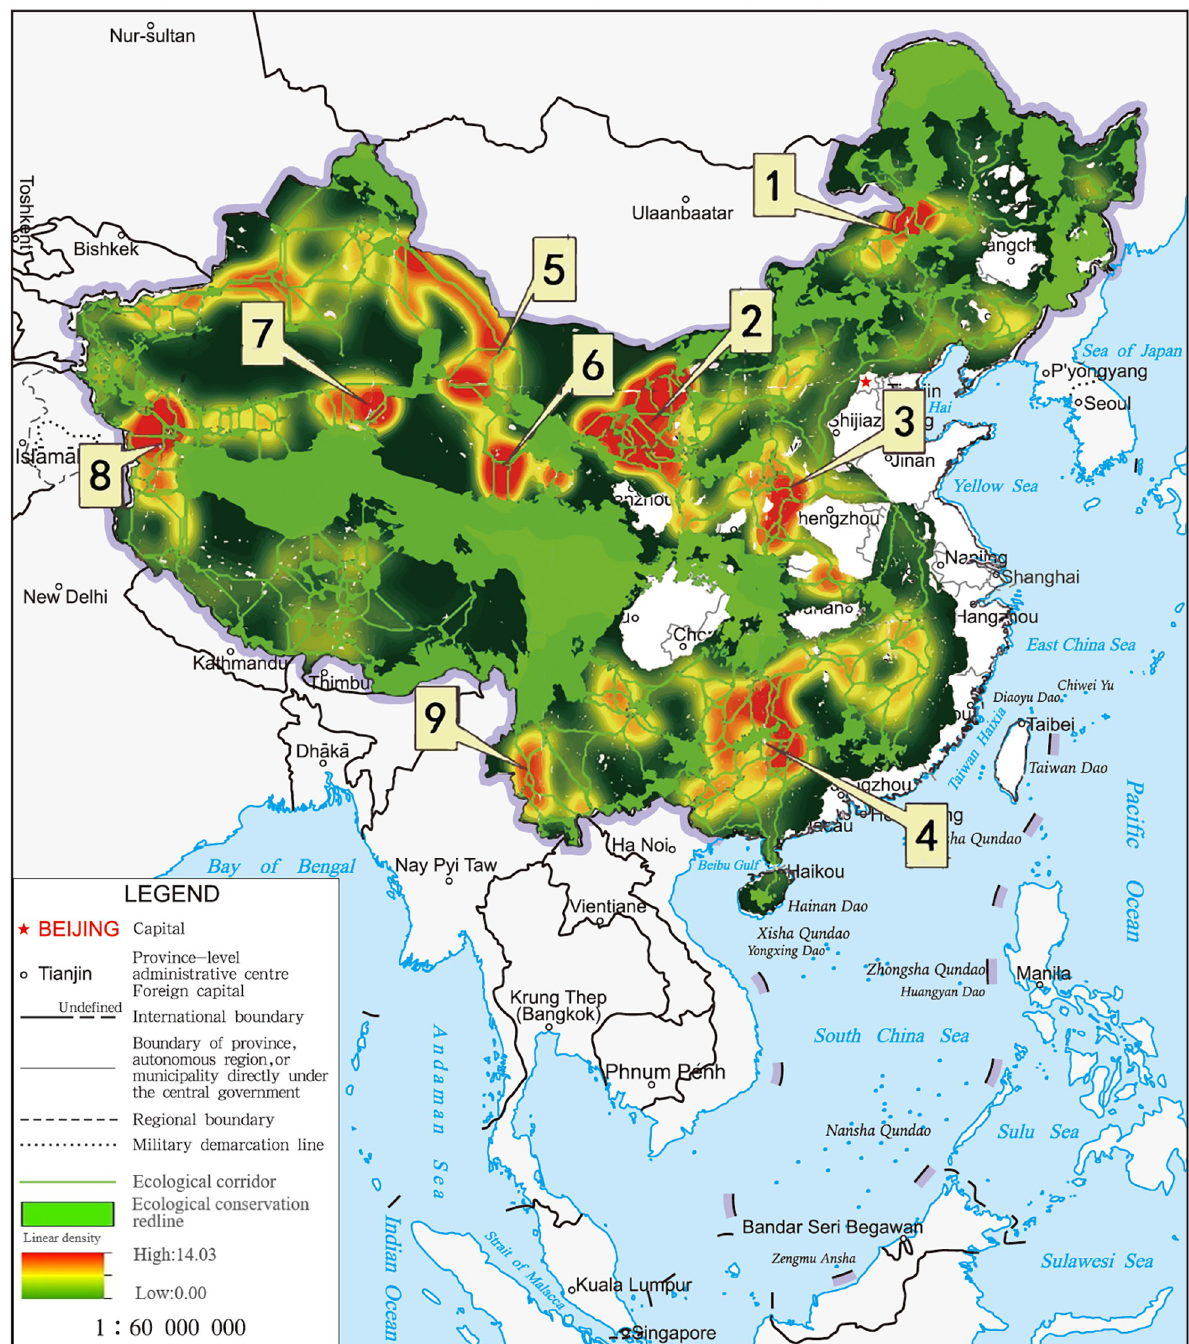
Fig 6. Diagrammatic map of key areas distribution of ecological corridors at the national scale.